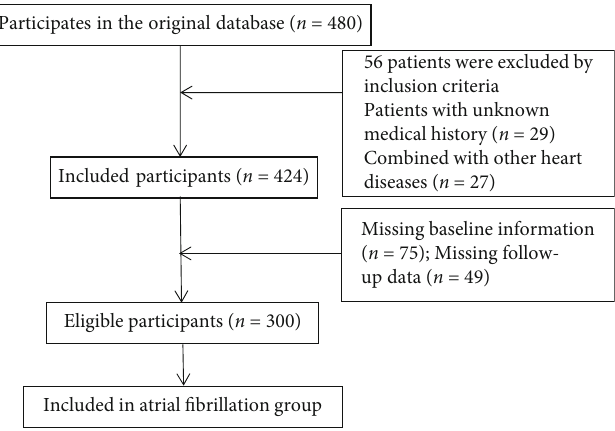
Figure 1: Flowchart of general data selection. Table 1: Comparison of general data of the two groups of patients ( (cid:1) x ± s ) [ n (%)].